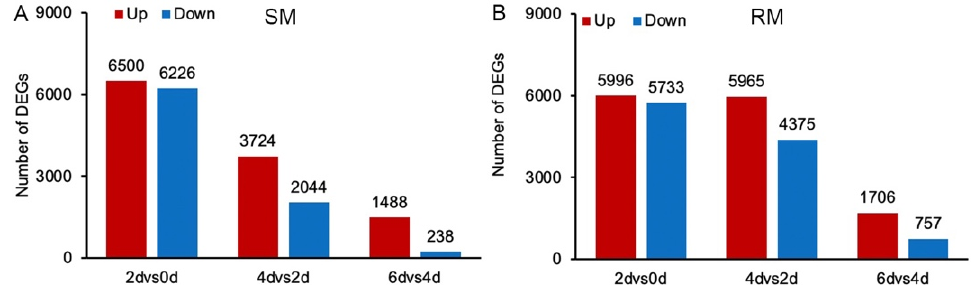
Figure 2. Number of DEGs in two maize inbred lines during low-temperature germination. ( A ) The number of up regulated and down regulated DEGs SM lines. ( B ) The number of up regulated and down regulated DEGs RM lines. SM: low-temperature sensitive maize inbred line; RM: low-temperature resistant maize inbred line.